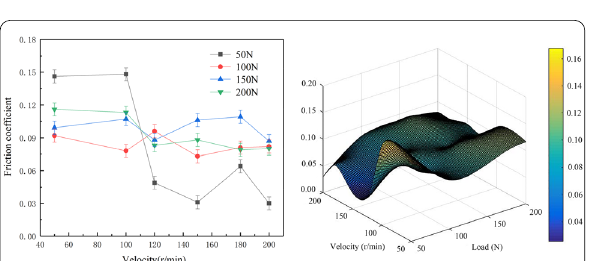
Figure 10 Experimental results of composite